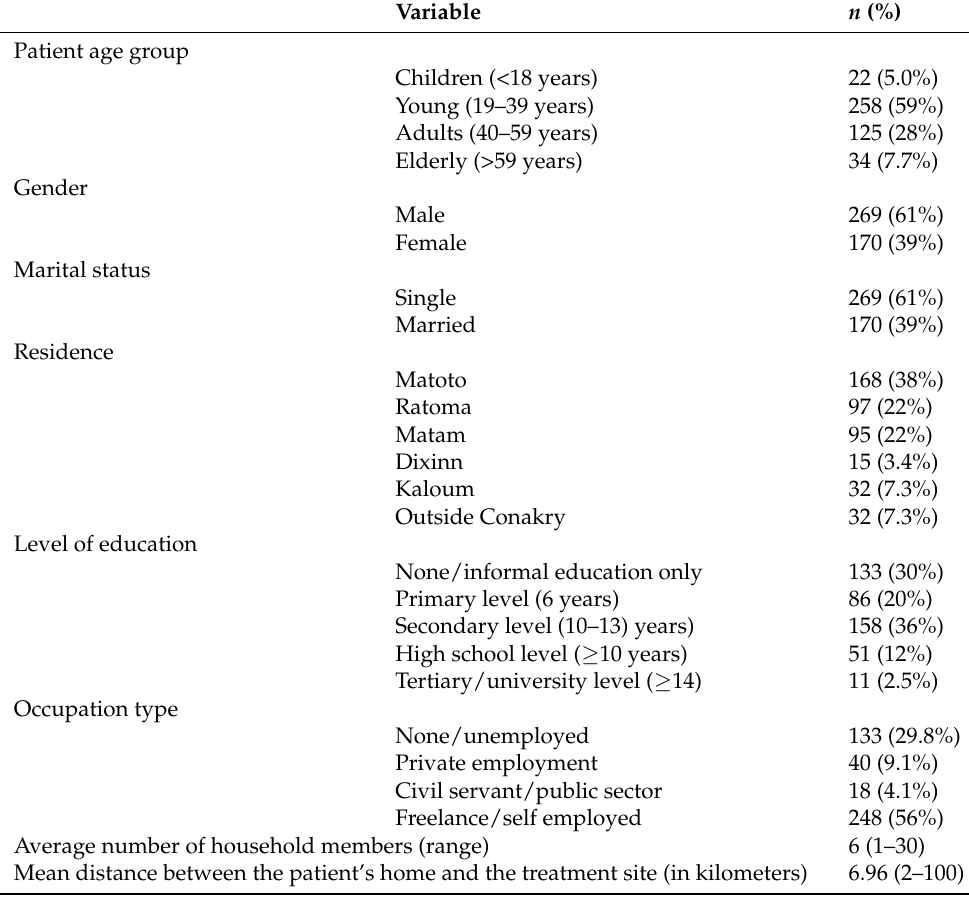
Table 1. Socio-demographic characteristics of the study sample ( n = 439).